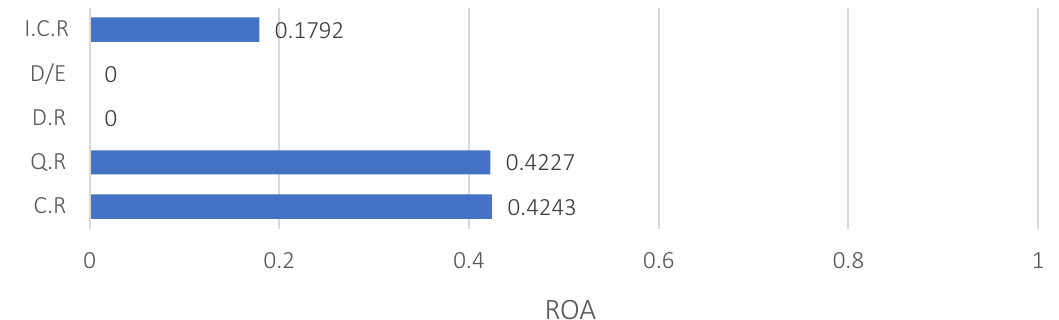
Figure 2. The relative impact of solvency, leverage, and liquidity on ROA